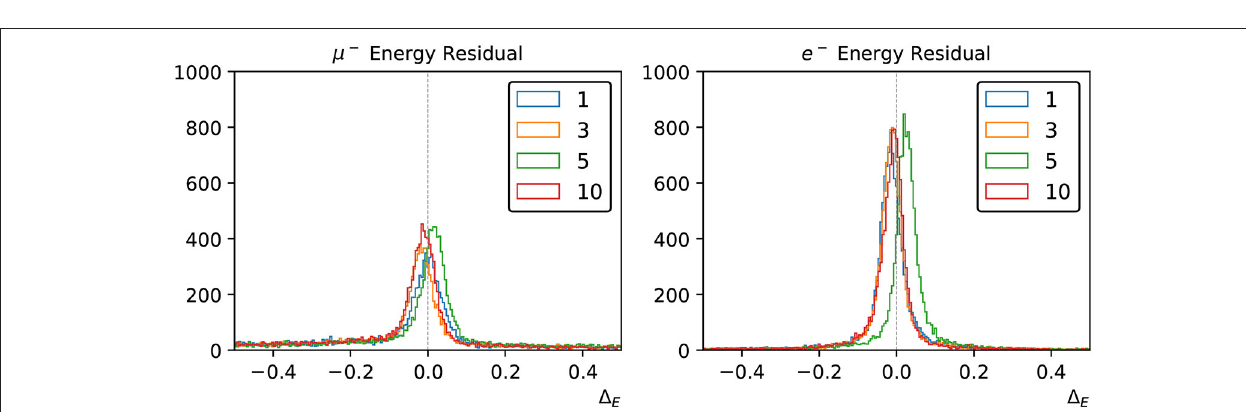
Figure 6 . The inadequacy of a single two-dimensional Gaussian to describe the data is more evident than in the one-dimensional case. This is expected, given the time distribution is multi- modal, with a sharp peak associated to Cherenkov photons